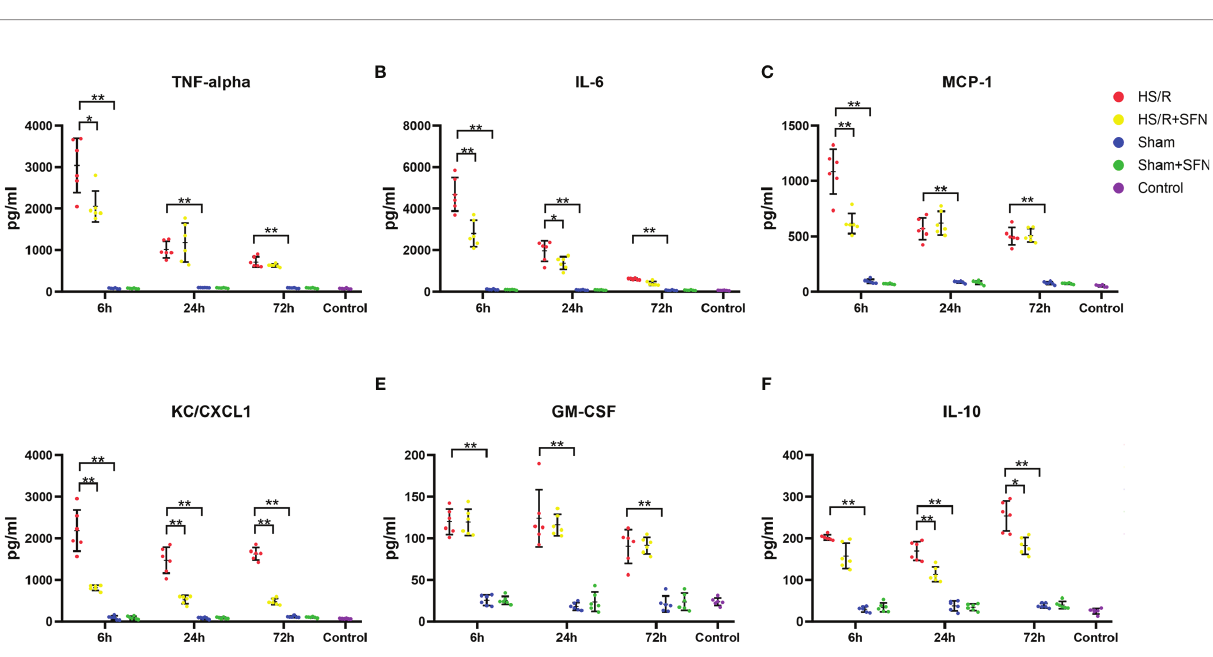
FIGURE 4 | Cytokines secreted by Kupffer cells (n=6 in each group). The TNF- a (A) , IL-6 (B) , MCP-1 (C) , KC/CXCL1 (D) , GM-CSF (E) , and IL-10 (F) levels in C57/ BL6 WT mouse plasma following HS/R or sham surgery with the HS/R + SFN group or sham + SFN group or without the administration of SFN (HS/R groups or sham groups). The results are expressed in pg/mL as mean ± SD. (*p < 0.05, **p < 0.01; the data of 6h group in graph (A) were analyzed by Kruskal-Wallis test followed by Dunn ’ s post hoc test, and others were obtained with use of one-way ANOVA followed by Tukey ’ s post hoc